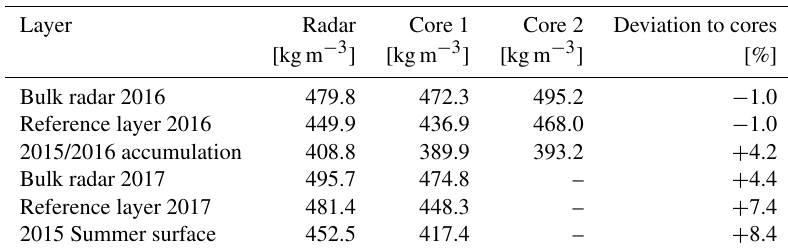
Table 1. Measured and radar determined densities for specific layers above the radar antennas. For comparison with core densities, we use the arithmetic mean of both cores.